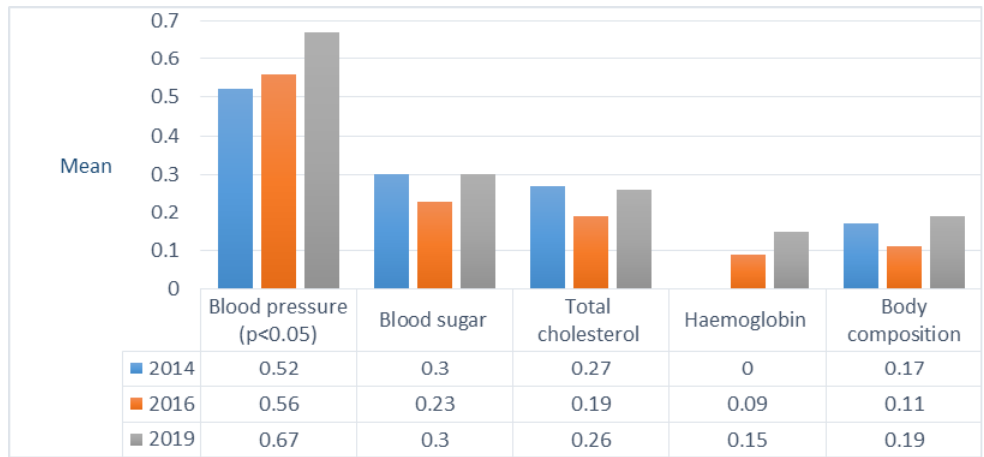
Figure 3. Provision of extended services based on evaluating the Community Pharmacy Service Quality Guideline (two- point scale) in